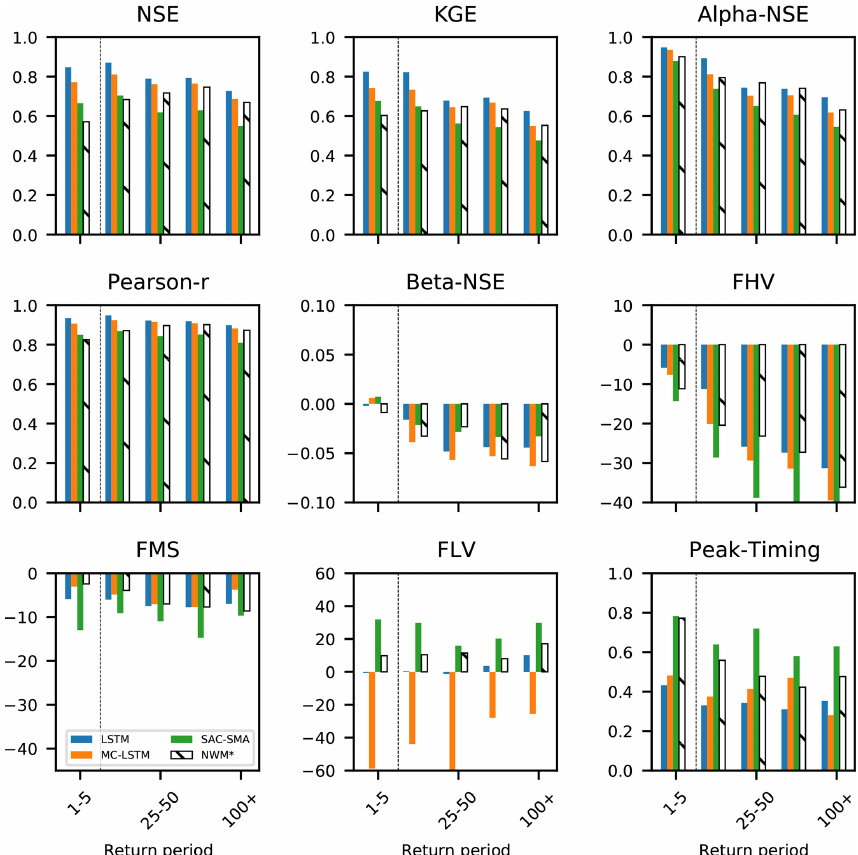
Figure C2. Metrics for the models trained only on high-probability years. The bins of return periods greater than 5 are out of sample for the LSTM, MS-LSTM, and SAC-SMA. The total number of samples in each bin is as follows: n = 5969 for 1–5, n = 1260 for 5–25, n = 185 for 25–50, n = 91 for 50–100, and n = 84 for 100 +